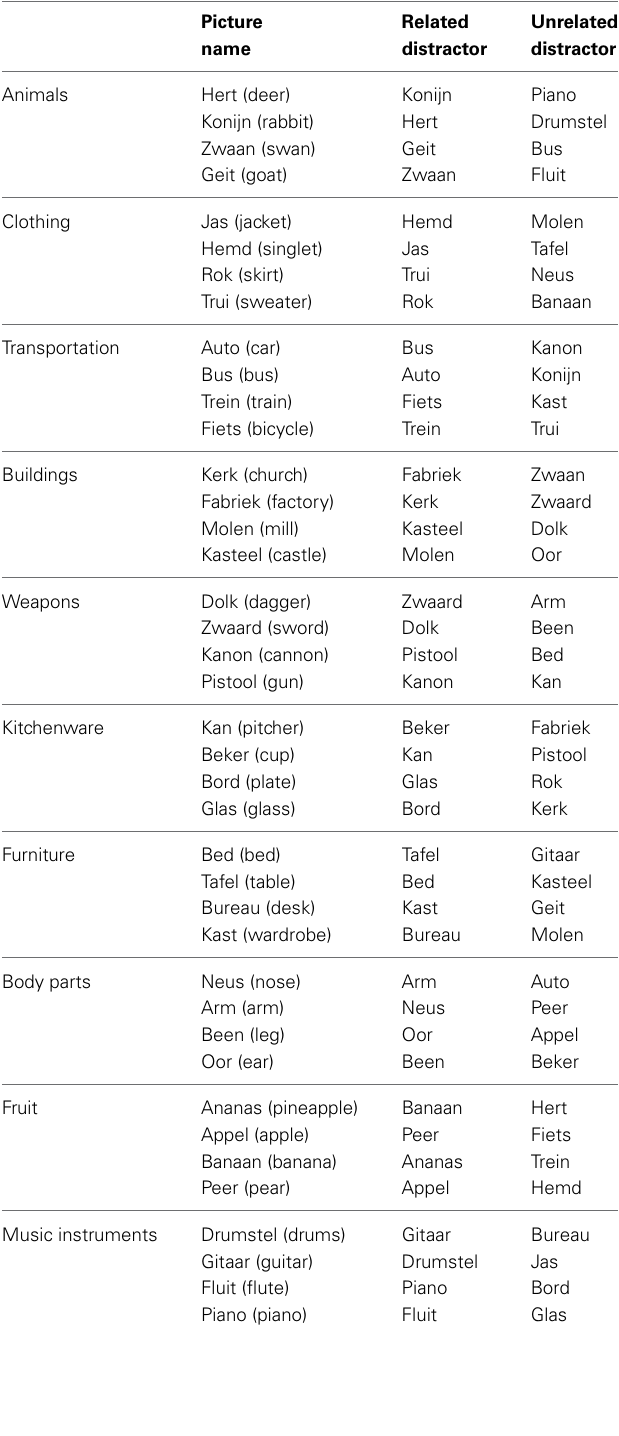
Table A1 | Materials from the experiment (English translations between